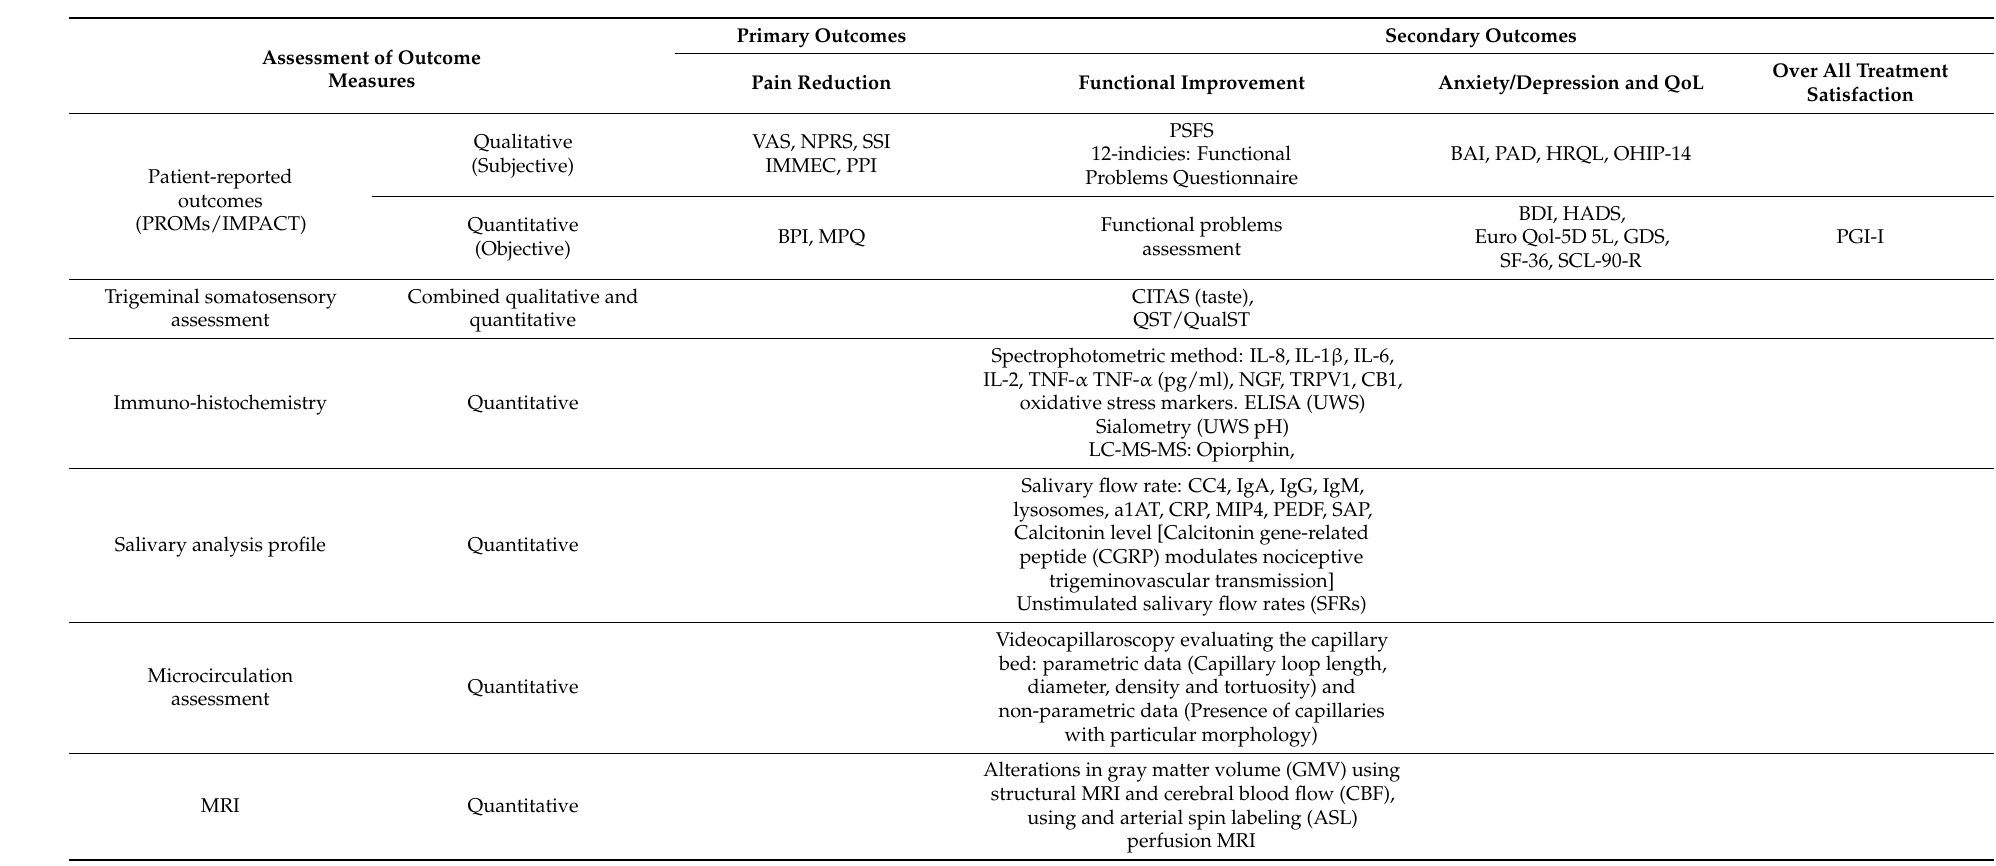
Table 5. Illustrates the qualitative and quantitative measurements for primary and secondary outcomes utilised in the selected studies of this review and further suggested quantitative assessments such as: salivary analysis, immunohistochemistry and MRI [92,93,96–110]. Abbreviations: IMMEC: Initiative on Methods, Measurement and Pain Assessment in Clinical Trials; SSI: symptoms’ severity index; BDI: Beck depression inventory; CITAS: chemotherapy-induced taste alteration scale; QST: quantitative sensory testing; QualST: qualitative sensory testing; PSFS; patient specific functional scale; IgA: immunoglobulin A; CRP, C-reactive protein; a1AT: α 1-Antitrypsin; PEDF, pigment epithelium-derived factor; SAP: serum amyloid P; MIP4: Macrophage Inflammatory Protein-4; CC4: complement C4; CB1: cannabinoid receptors type 1; LC-MS-MS: liquid chromatography with tandem mass spectrometry;